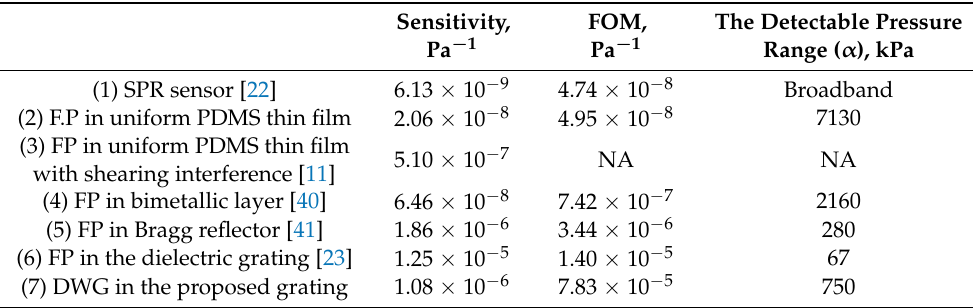
Table 1. Performance parameters for optical detection of ultrasound for different modes and